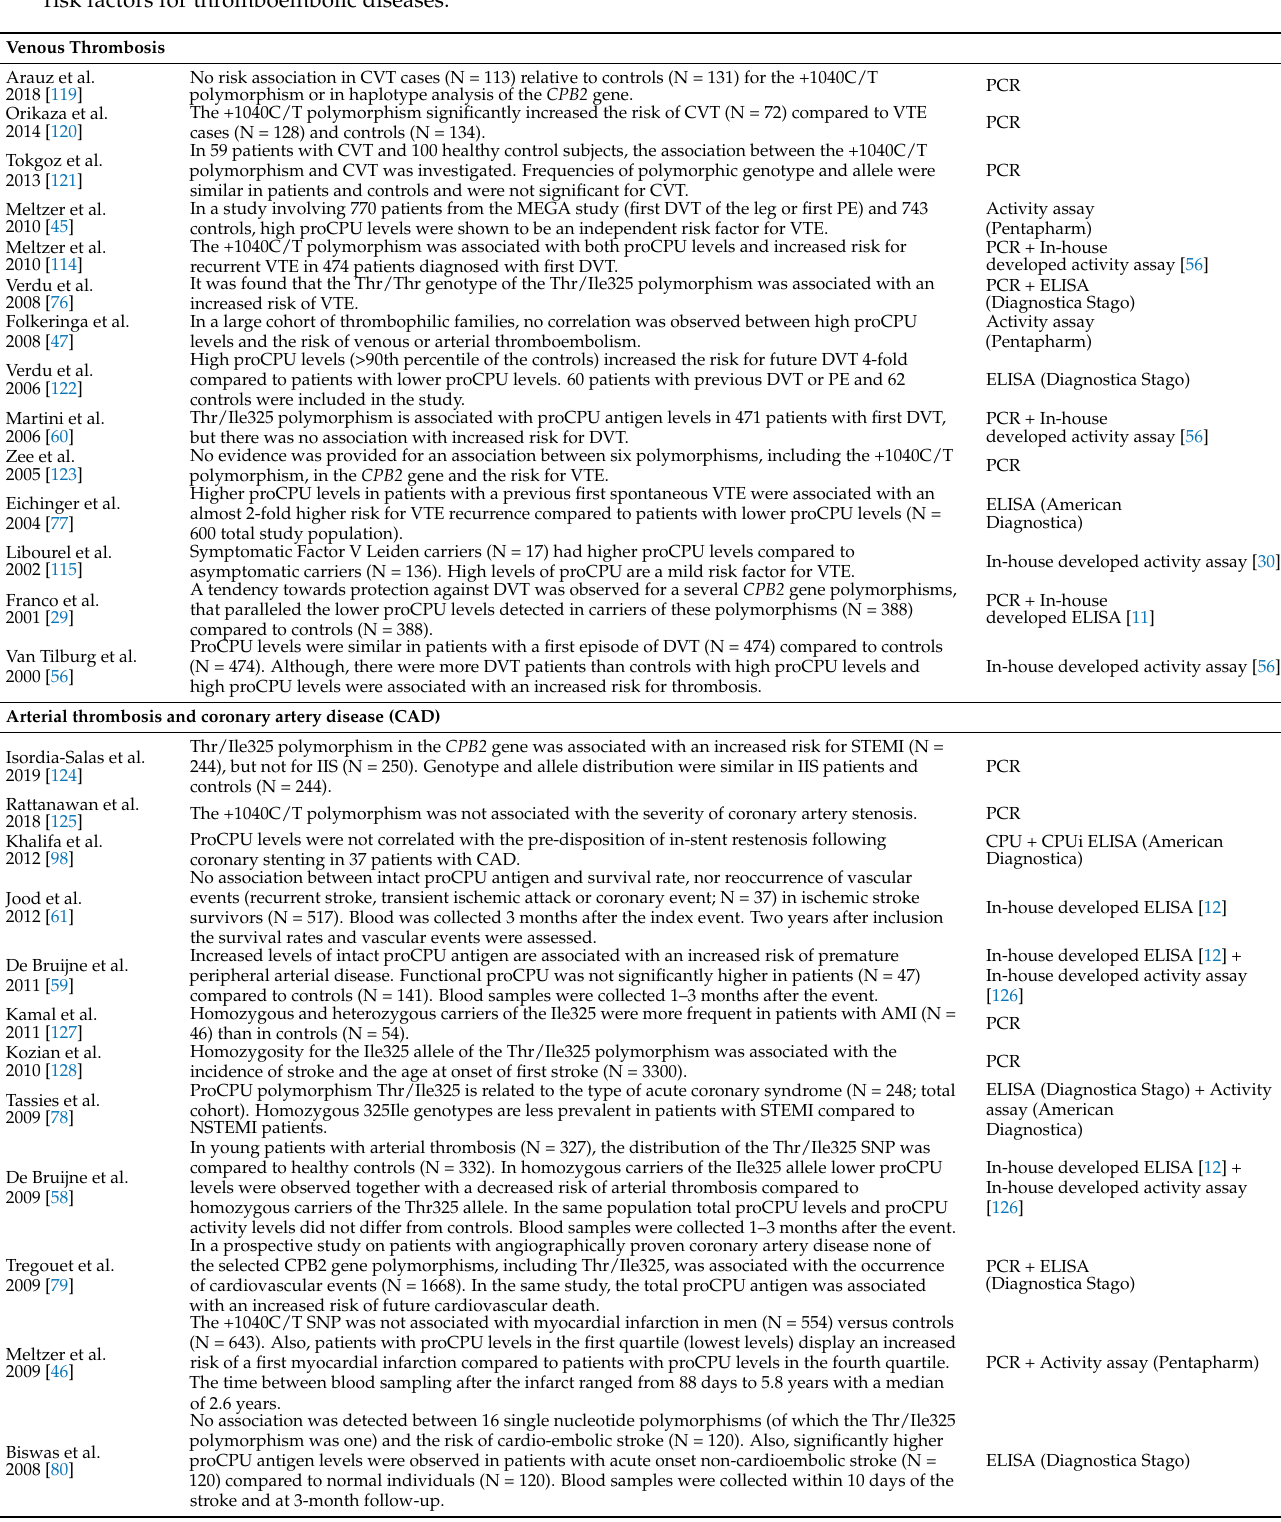
Table 2. Studies investigating the role of proCPU plasma concentrations and proCPU gene ( CPB2 gene) polymorphism as risk factors for thromboembolic